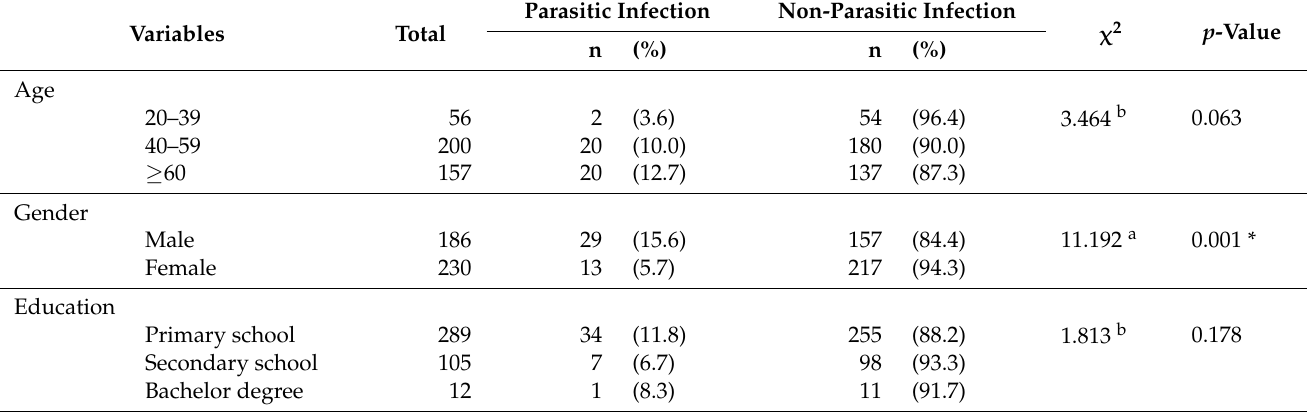
Table 1. Socio-demographic data and health behavioral factors related to parasitic